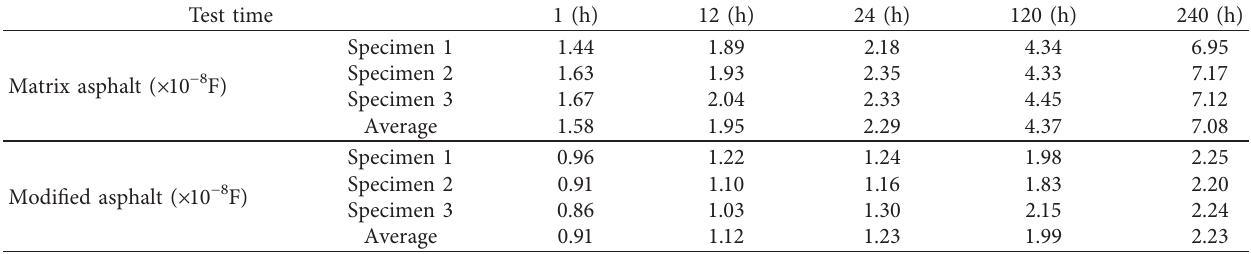
Table 6: The change of asphalt film capacitance with time.